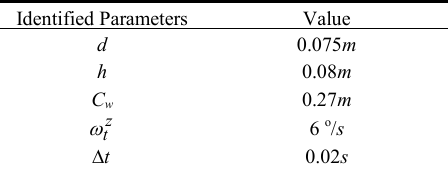
Table 1. Omni-directional walking parameters.